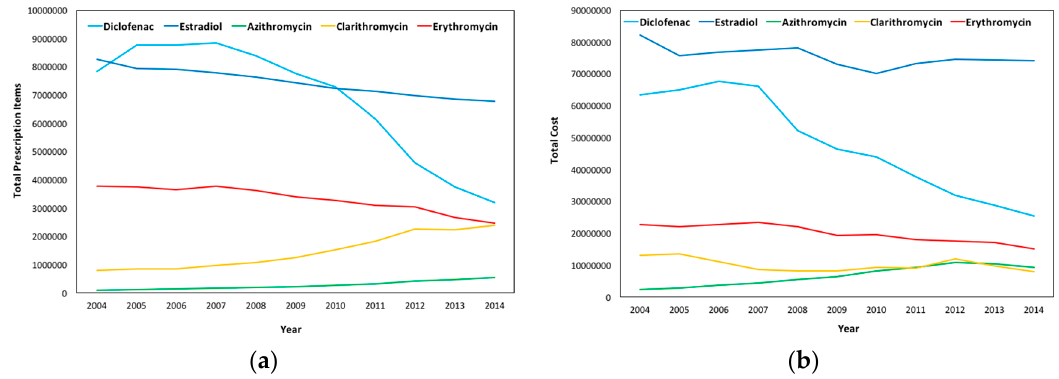
Figure 8. England’s Total ( a ) Prescription Items and ( b ) Cost (£) per substance from 2004 to 2014.